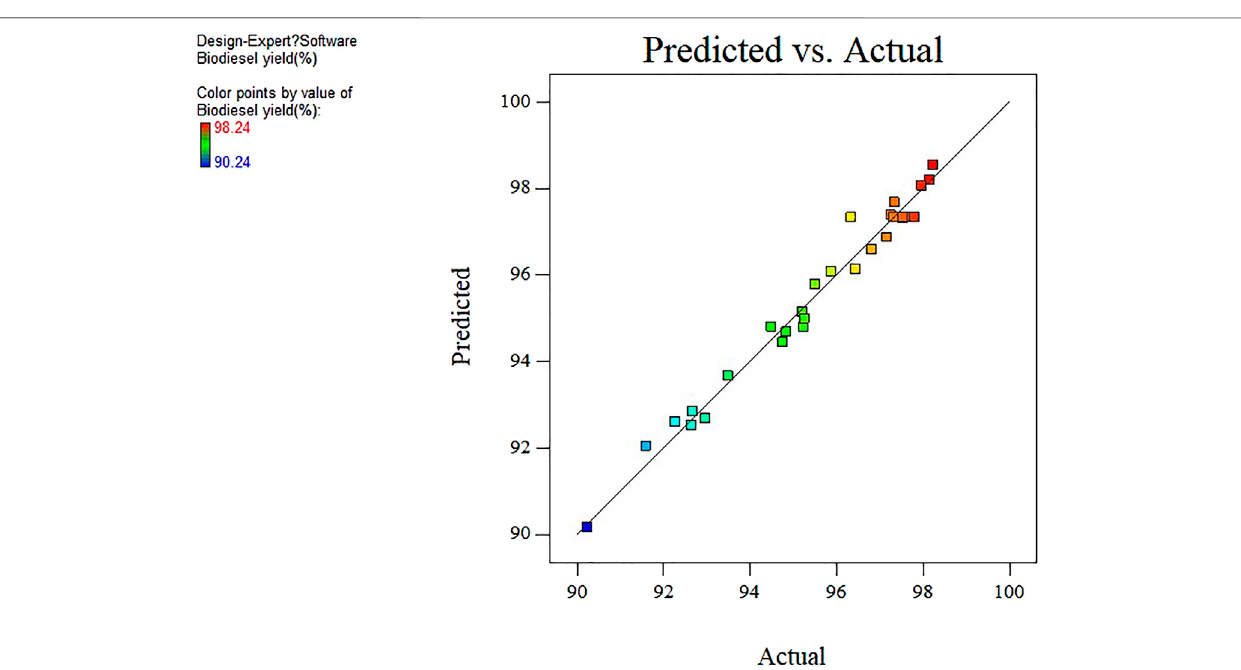
FIGURE 4 | Comparison of experimental and predicted